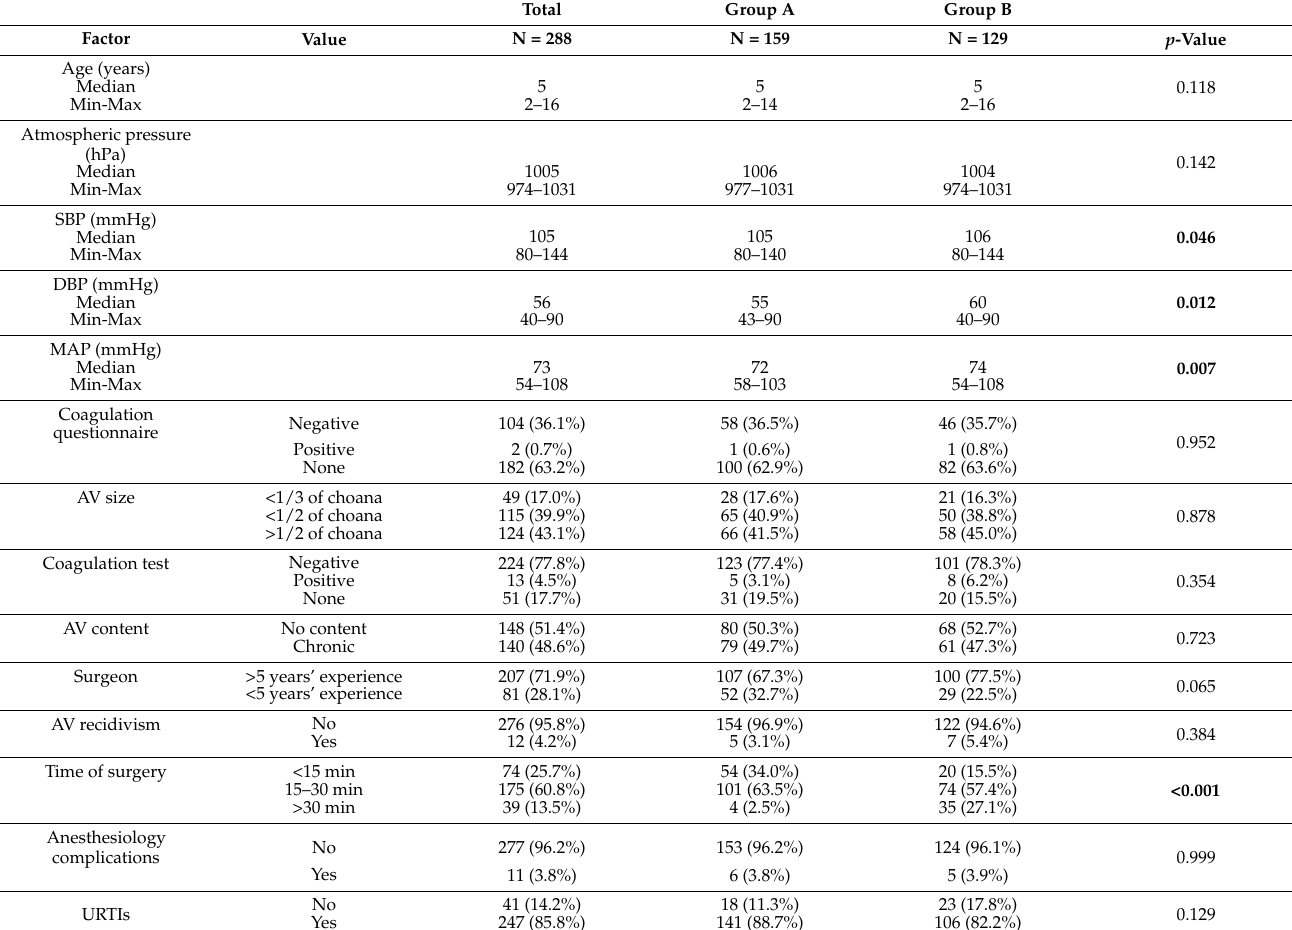
Table 1. Characteristics of patients in analyzed groups.